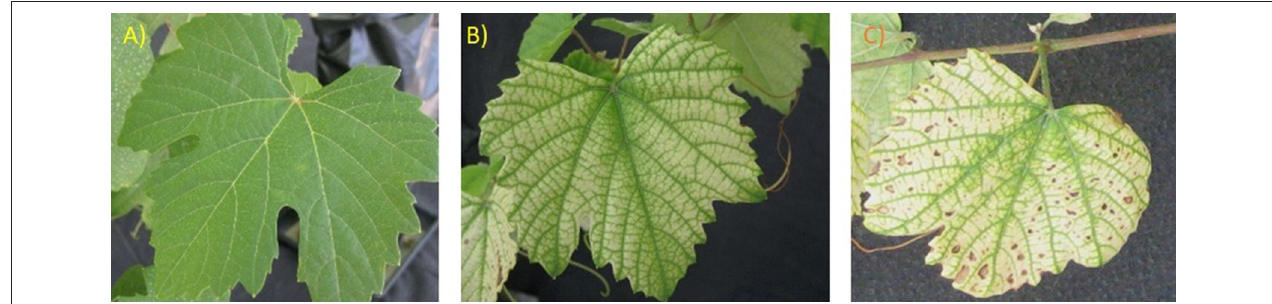
FIGURE 4 | (A) Non-symptomatic leaf of a grapevine plant grown in the non-contaminated Arenosol. (B) Interveinal chlorosis symptoms in a grapevine plant growing in the Cu-contaminated Arenosol. (C) Chlorosis and dark spots in a grapevine plant growing in the Cu-contaminated